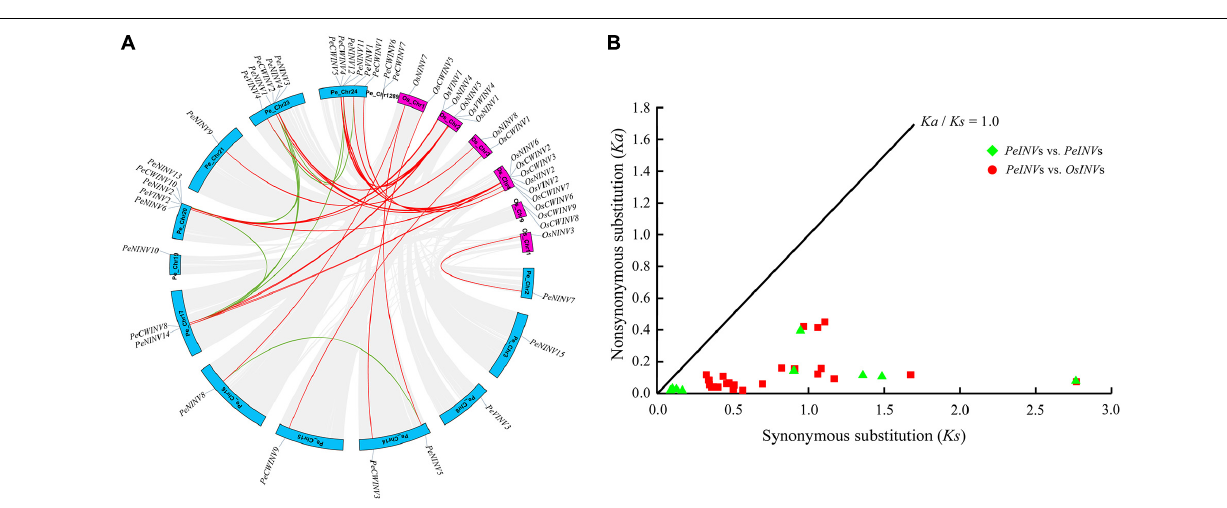
Frontiers in Genetics |